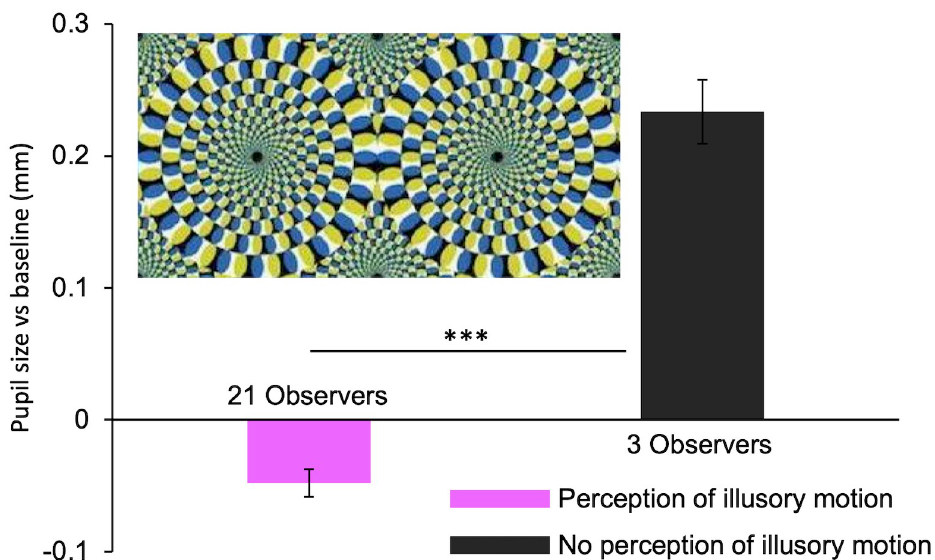
Fig 7. Effect of perception of illusory motion. The image shown (n˚ 81 of S1 List) is the one scoring the highest number of misinterpretations (3). Asterisks mark statistically significant comparisons between groups, non-parametric one-tailed Mann-Whitney test, ��� p <